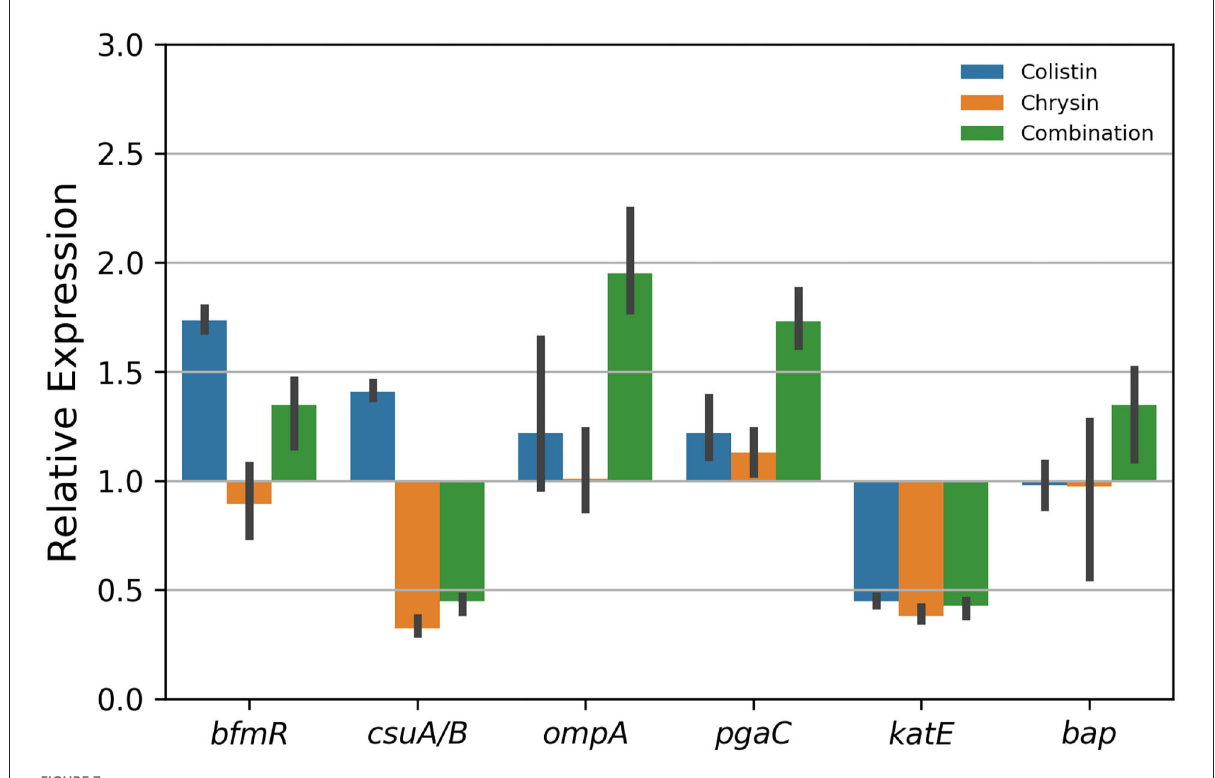
FIGURE7 Gene expression of the biofilm of A. baumannii